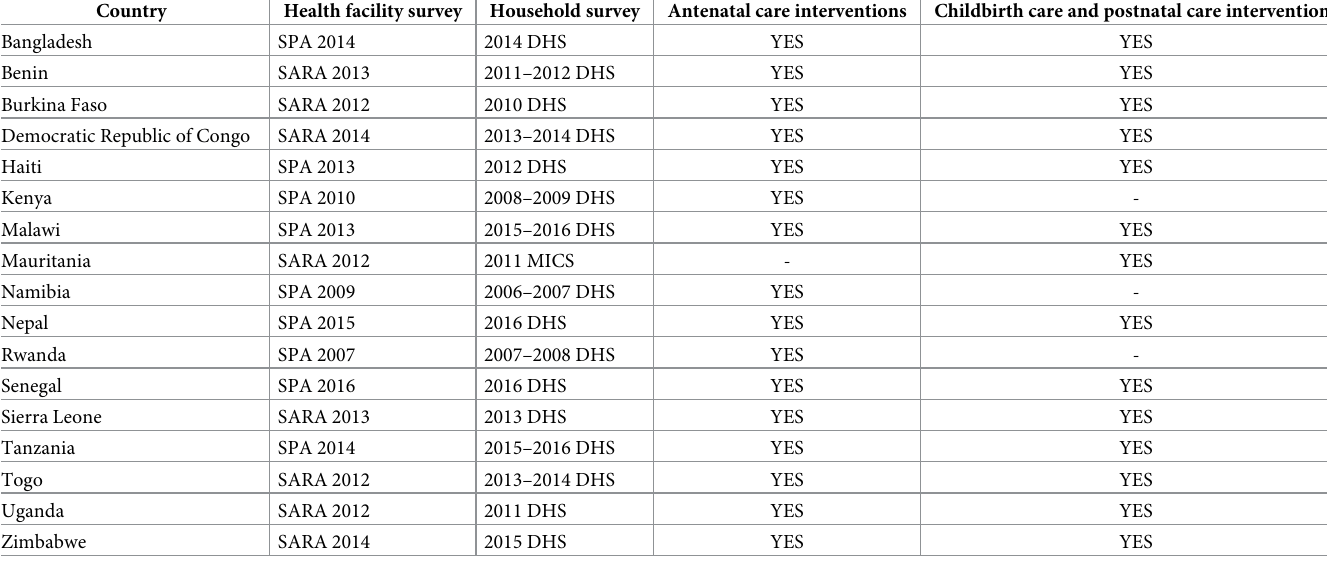
Table 1. Linked datasets used to estimate baseline coverage of